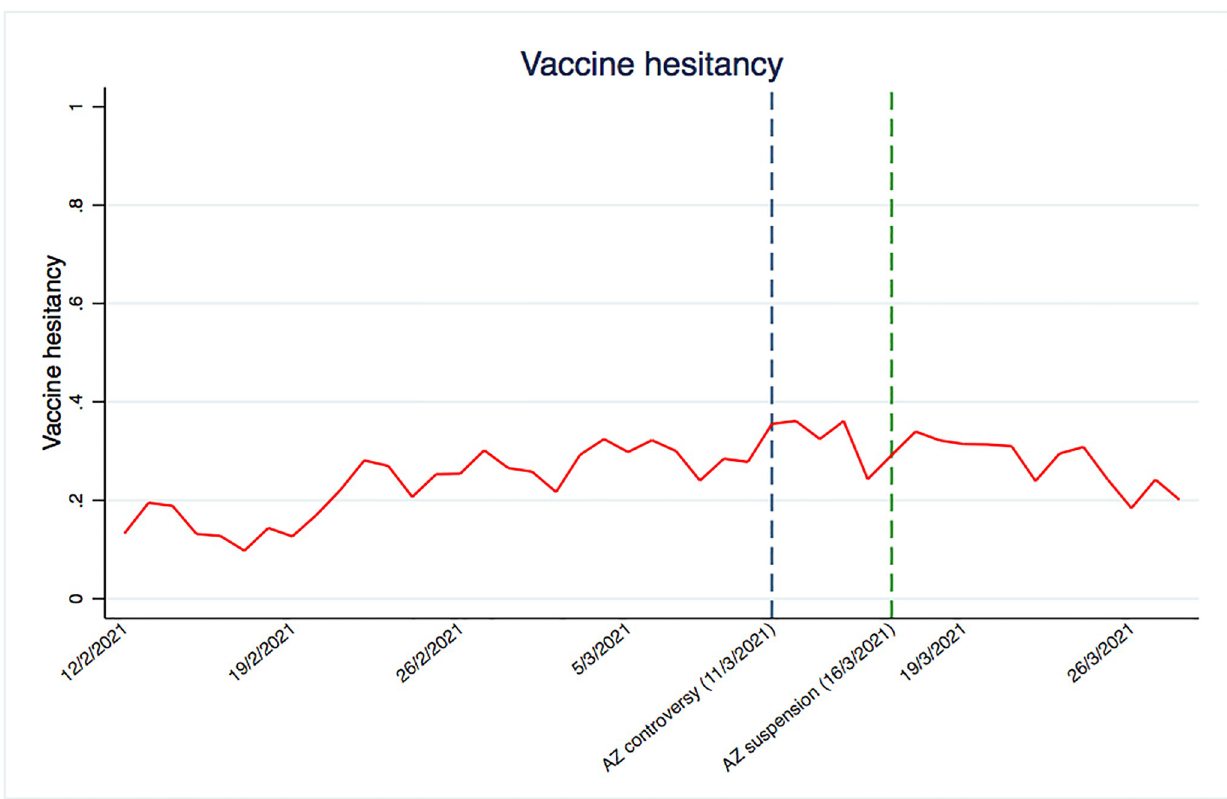
Fig 2. Vaccine hesitancy time-trend. Notes: the graph shows the time-trend of the vaccine hesitancy during the period from 12 February 2021 to 28 Marrh 2021 The blue dashed line represents the moment of the AstraZeneca controversy, coinciding with 11 March 2021, while the green dashed line represents the date when the AstraZeneca vaccine was suspended across a number of countries (16 March